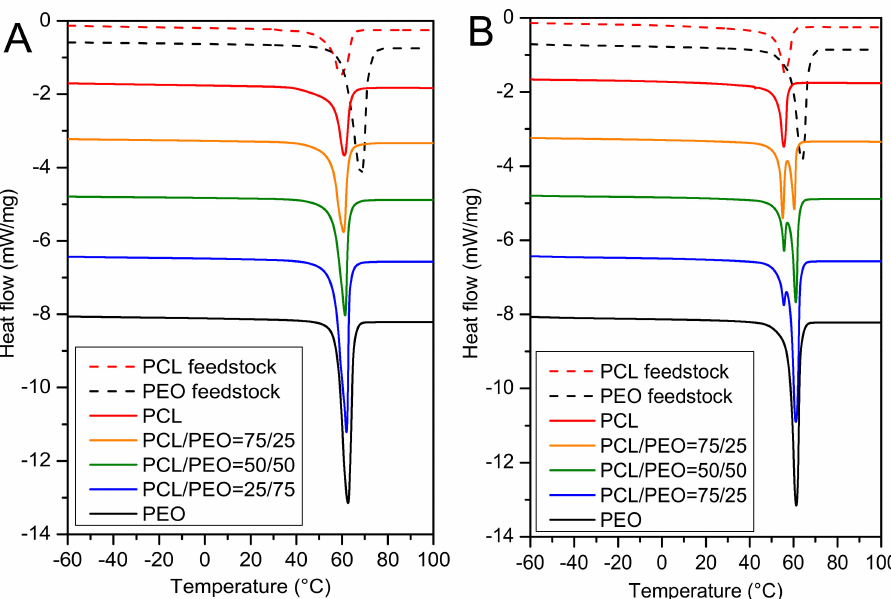
Figure 3. DSC thermographs of ( A ) the first heating cycle showing a single melting peak, and ( B ) the second heating cycle revealing two melting peaks demonstrating two separate polymers in the mixed samples. Only the as-prepared PCL, PCL75 / PEO25, PCL50 / PEO50, PCL25 / PEO75 and PEO samples are shown for a better clarity of the graphs. The thermographs of all the samples can be found in Supplementary Information Figure